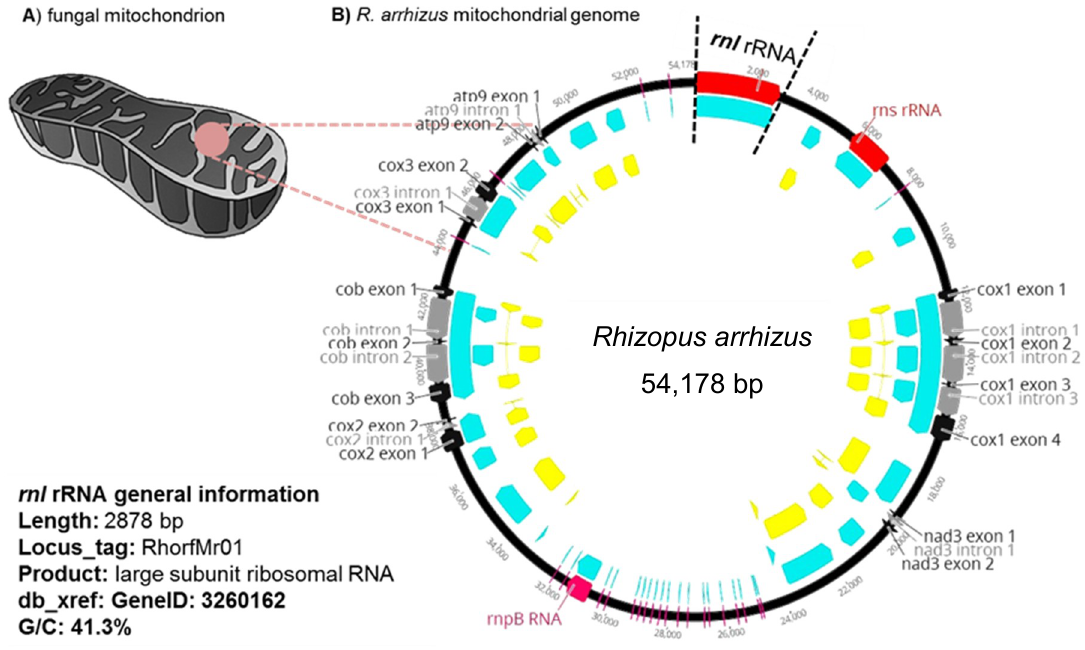
Figure 1. Location of the rnl gene (a large subunit of the ribosomal RNA) in the mitochondrial genome of R. arrhizus. ( A ) shows a fungal mitochondrion. ( B ) provides an overview on the mitochondrial genome.